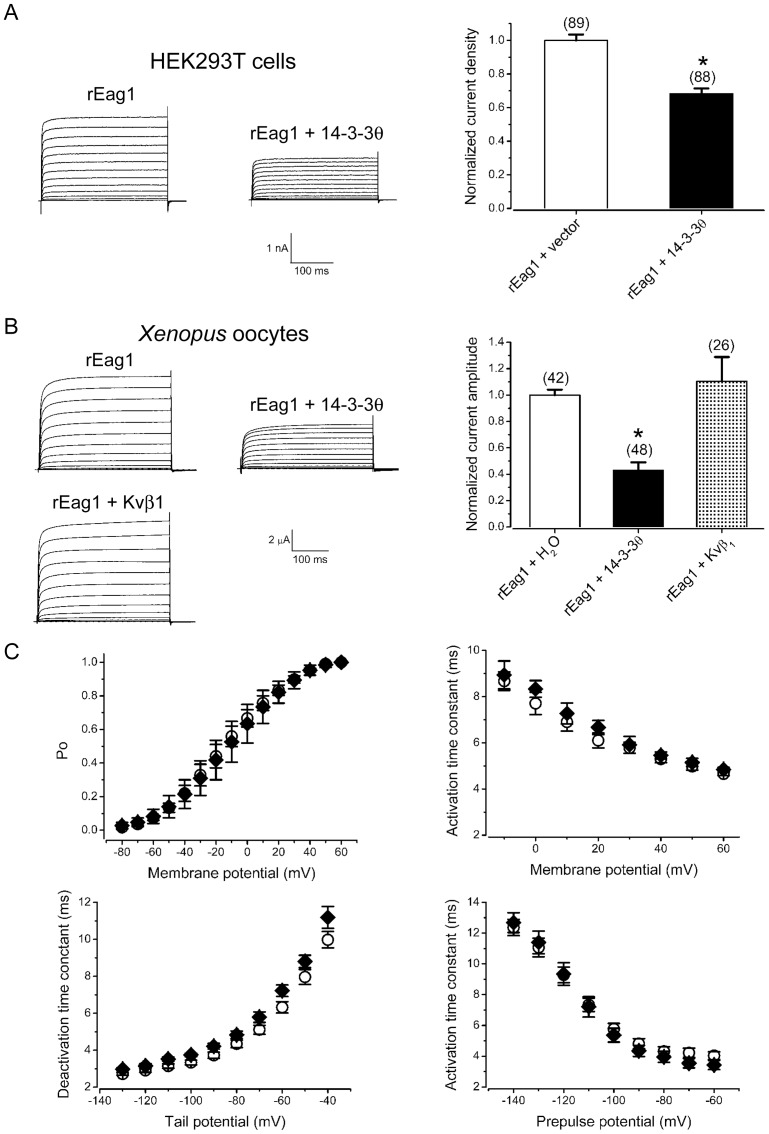
The effect of 14-3-3θ over-expression on rEag1 K+ currents.
(
A
) (Left panel) Representative K+ currents recorded from HEK293T cells expressing rEag1 in the absence or presence of 14-3-3θ. HEK293T cells were co-transfected with the cDNAs for rEag1 and myc-vector or myc-14-3-3θ in the molar ratio of 1∶5. The holding potential was −90 mV. The pulse protocol comprised 300-ms depolarizing test pulses ranging from −90 to +50 mV, with 10-mV increments. (Right panel) Normalized mean K+ current density (at +40 mV) of rEag1 channels in the absence or presence of myc-14-3-3θ. The numbers in the parentheses refer to the number of cells analyzed, and the asterisk denotes significant difference from the rEag1 control (*, t-test: p<0.05). (
B
) (Left panel) Representative K+ currents recorded from oocytes expressing rEag1 in the absence or presence of 14-3-3θ. The molar ratio for cRNA co-injection was 1∶5 and 1∶10 for 14-3-3θ and Kvβ1, respectively. The pulse protocol was identical to that described in (A). (Right panel) Normalized mean K+ current density (at +40 mV) of rEag1 channels in the absence or presence of 14-3-3θ. (
C
) Biophysical properties of rEag1 channels in the absence (open circles) or presence (filled diamonds) of 14-3-3θ. The voltage-dependant curves for steady-state activation (upper left panel), activation kinetics (upper right panel), deactivation kinetics (lower left panel), and non-superimposable Cole-Moore shift (lower right panel) were analyzed as described previously [17]. Data were collected from recordings performed in oocytes.